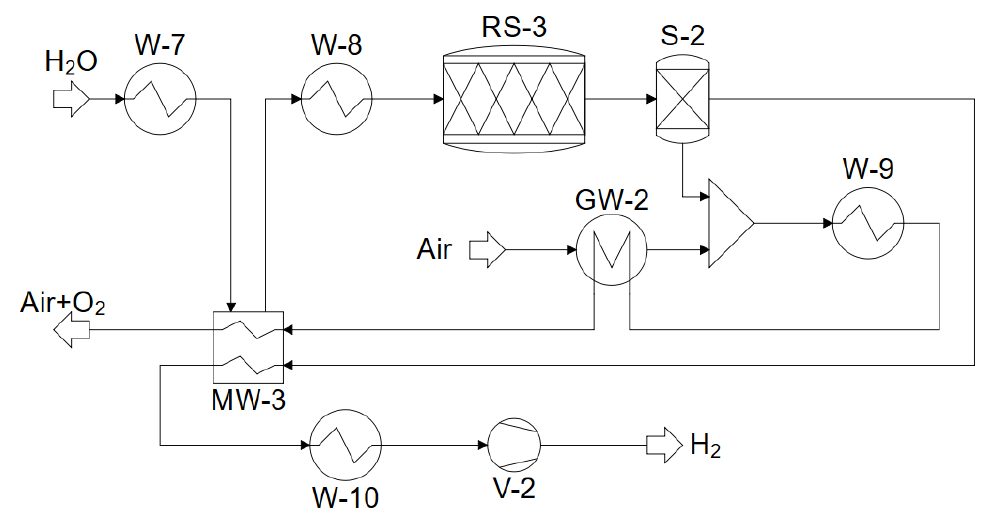
Figure 3. Excerpt from the process flow diagram: water electrolysis.